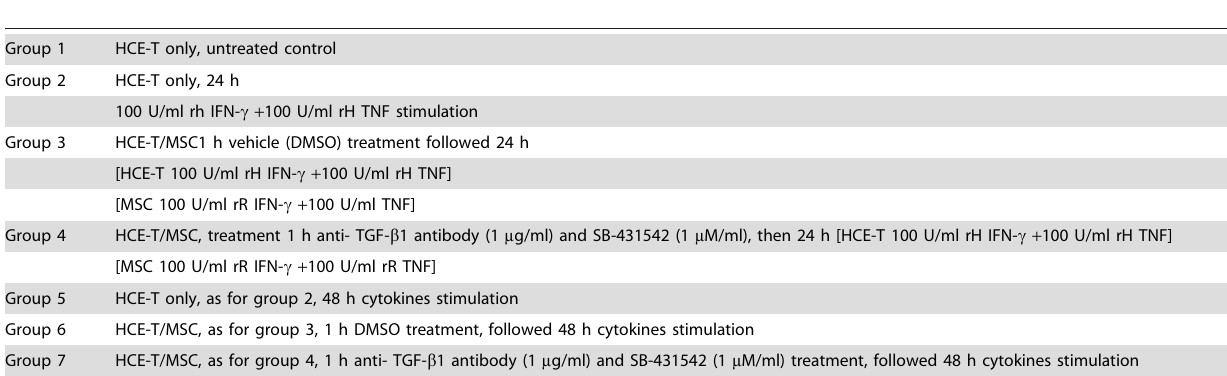
Table 5. Groups for TGF- b 1 signaling pathway experiments.